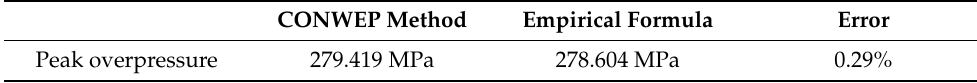
Table 3. Comparison of peak overpressure.